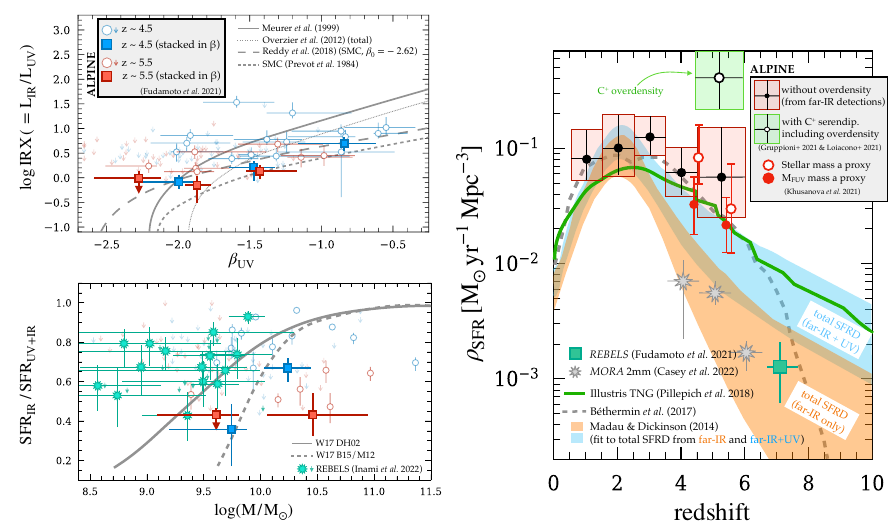
Figure 5. Dust obscuration and total SFR density from the ALPINE sample. Left Panels: IRX − β re- lation ( top ) and total obscured fraction of SFR as a function of stellar mass ( bottom ) [92]. Individual ALPINE galaxies at z ∼ 4.5 and z ∼ 5.5 are indicated in blue and red circles (and limits). Stacked measurements in bins of β and stellar mass, respectively, are shown with filled squares. On the IRX − β diagram, we also show SMC-like dust (short-dashed line; [113]), the starburst relation (solid line; [99]) and the updated local relation (dotted line; [114]), and the relation by Reddy et al. [115] for β 0 = − 2.62 (long-dashed line). On the obscured fraction vs. stellar mass diagram, we also show the REBELS sample (only with ALMA redshift, teal stars; [116]) and the 250 µ m data from Whitaker et al. [117] at z = 0–2.5 using the far-IR template from Dale and Helou [118] (solid line) and Béthermin et al. [119] or Magdis et al. [120] (dashed line) for the calculation of the total SFR. Figures adapted from Fudamoto et al. [92]. Right Panel: Total SFR density as a function of redshift derived from the ALPINE blind sample (black circles and red squares; [66]) and stacked far-IR measurements (red symbols; [109]). We also include the result from serendipitous C + detections that show a higher density because of clustering with the ALPINE main targets [43]. Measurements from the MORA 2mm ALMA survey (far-IR SFRs only) from Casey et al. [112] are shown as gray stars. The predictions from Illustris TNG (green line [110]) and Béthermin et al. [111] (dashed line) are also shown. The total SFR density fits for SFR IR and SFR UV + IR data from the Madau and Dickinson [7] review are shown as orange and blue swaths, respectively. Adapted from Ref.